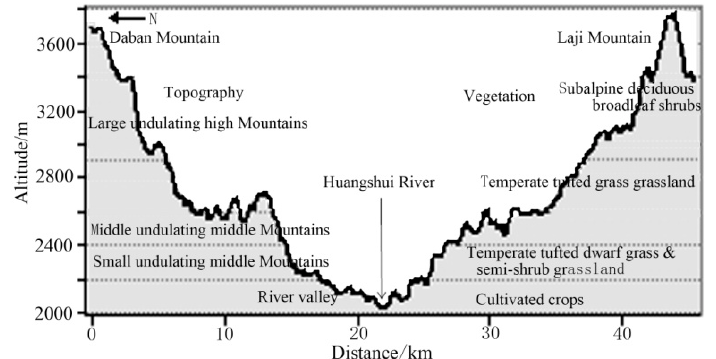
Figure 2. Topographic section and vertical zonality distribution of vegetation on Hehuang valley (corresponding to the topographic section line in Figure 1).